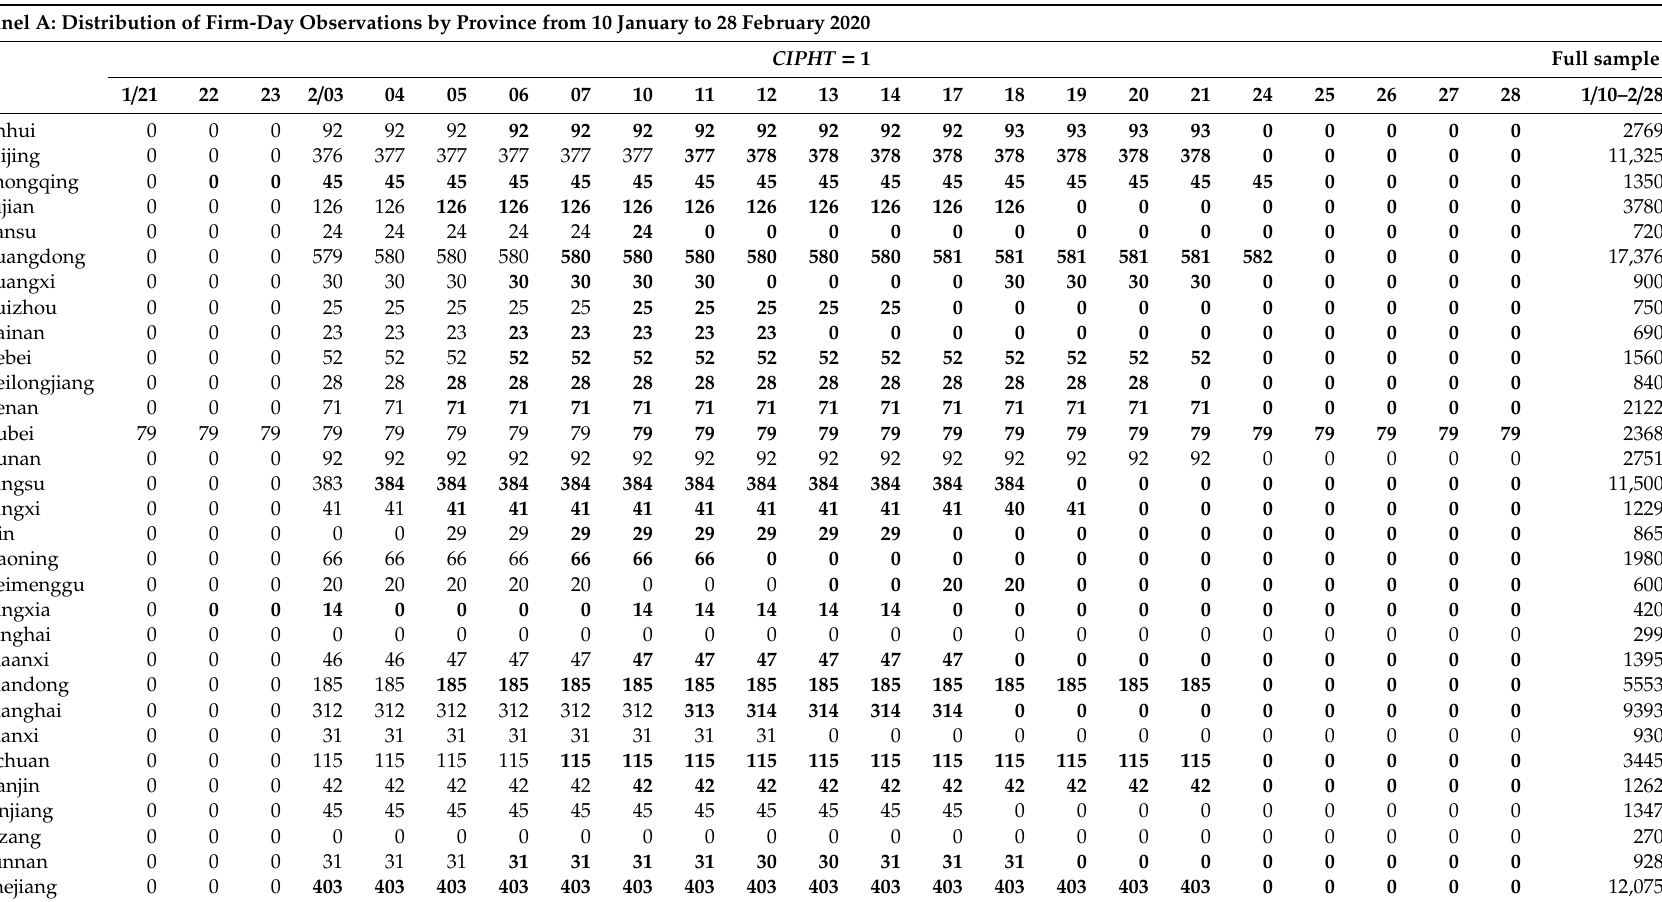
Table A2. Distribution of firm-day observations by province and